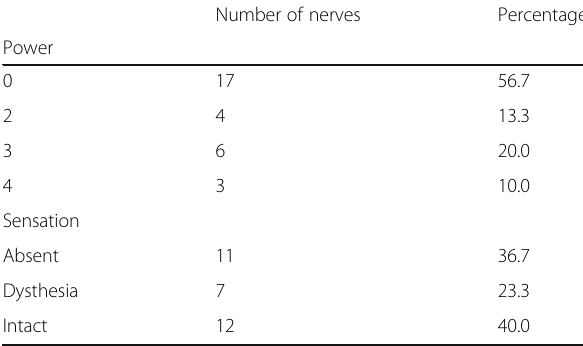
dermatomes of the affected nerves Number of